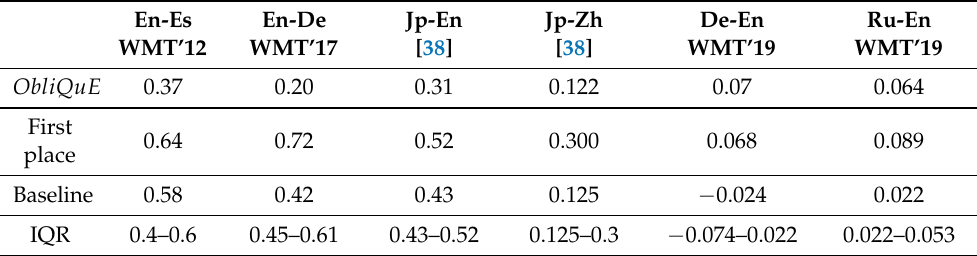
Table 1. Correlation with human judgment scores for various language pairs. The bottom three rows refer to scores achieved by other competitors. IQR stands for the interquartile range of the competitors. Complete detail in Section